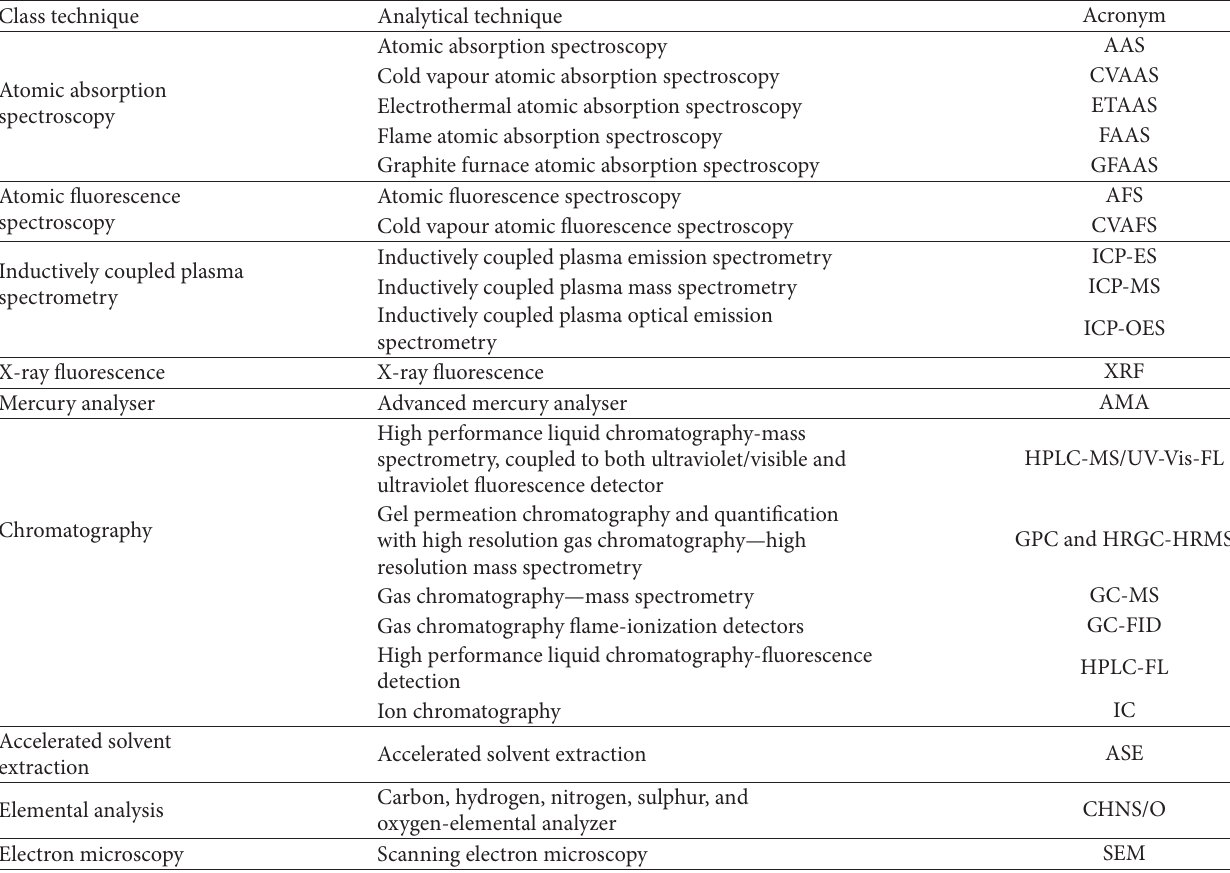
Table 14: List of the main analytical techniques and classes used in deposition studies, with